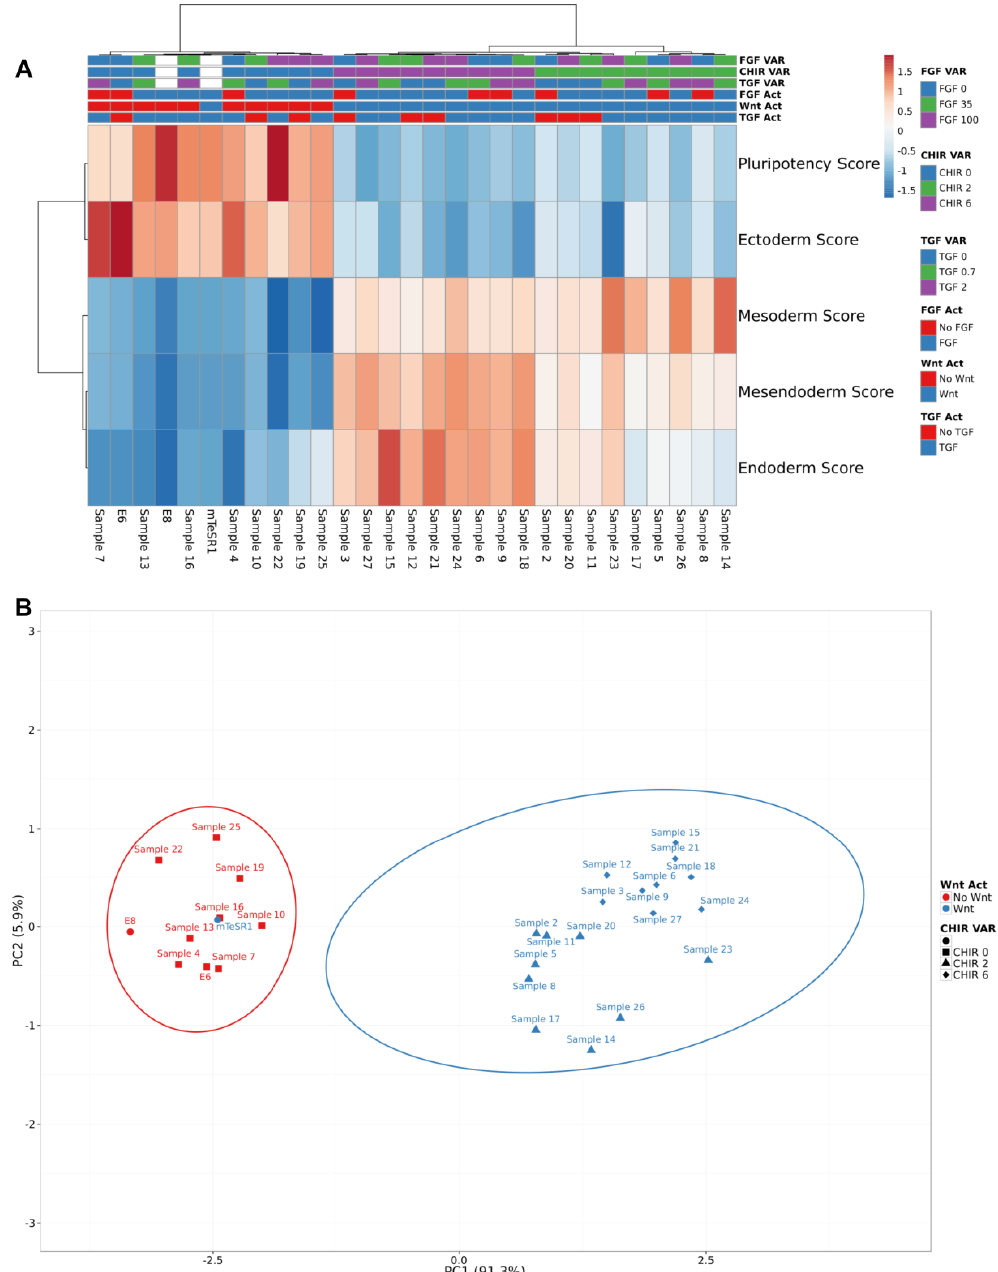
Figure 3. Hierarchical clustering and PCAs of full factorial design scores revealed two main clusters concordant with the presence or absence of CHIR. ( A ) Two main clusters were observed: Wnt activation, characterized by higher scores to mesendoderm lineages; and No Wnt activation, characterized by higher pluripotency and ectoderm scores. Clustering was performed using Pearson correlation and average linkage. Samples were labelled using signaling activation and no activation (FGF Act, Wnt Act and TGF Act; red and blue) and concentration variation (FGF VAR, CHIR VAR and TGF VAR; blue, green and purple). ( B ) The two main principal components together explained 97.2% of total data set variance. PC1 variance (91.3% of data set) corresponds to Wnt modulation. Only mTeSR1 clustered within the “No Wnt” group.